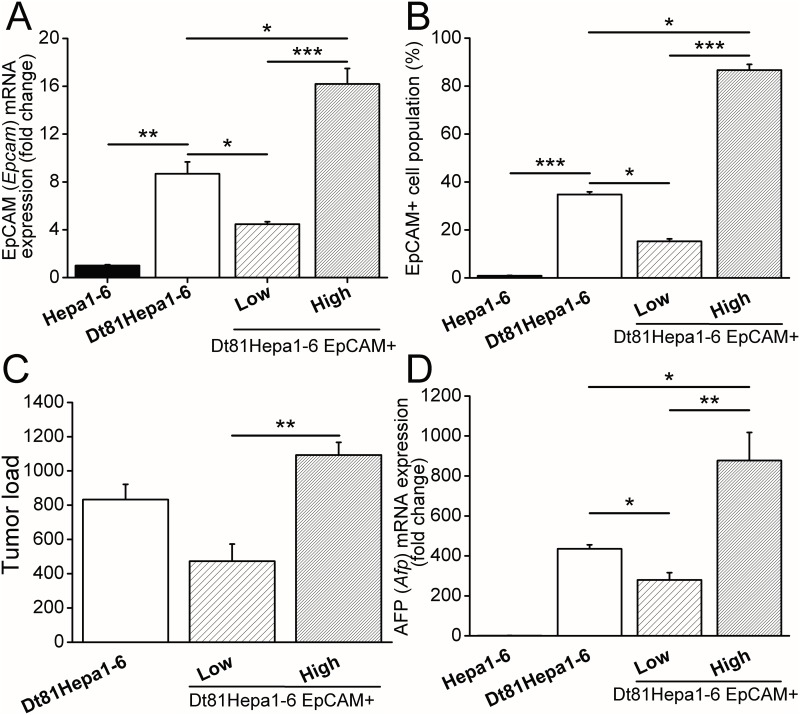
EpCAM+ Dt81Hepa1-6 cells are highly tumorigenic.Dt81Hepa1-6 cells were incubated with APC-tagged anti-CD326 (EpCAM) antibody and sorted by FACS as EpCAM+high and EpCAM+low Dt81Hepa1-6 cells. Hepa1-6, Dt81Hepa1-6, EpCAM+high and EpCAM+low were analyzed by (A) qPCR for EpCAM mRNA expression and (B) flow cytometry after labeling with APC-tagged anti-CD326 (EpCAM). Dt81Hepa1-6, EpCAM+low and EpCAM+high were injected intrasplenically in C57BL/6 mice and sacrificed after 21 days. (C) Tumor load (>0.5mm) was assessed and (D) AFP mRNA expression was compared to healthy liver controls. (*P<0.05; **P<0.01; ***P<0.001).